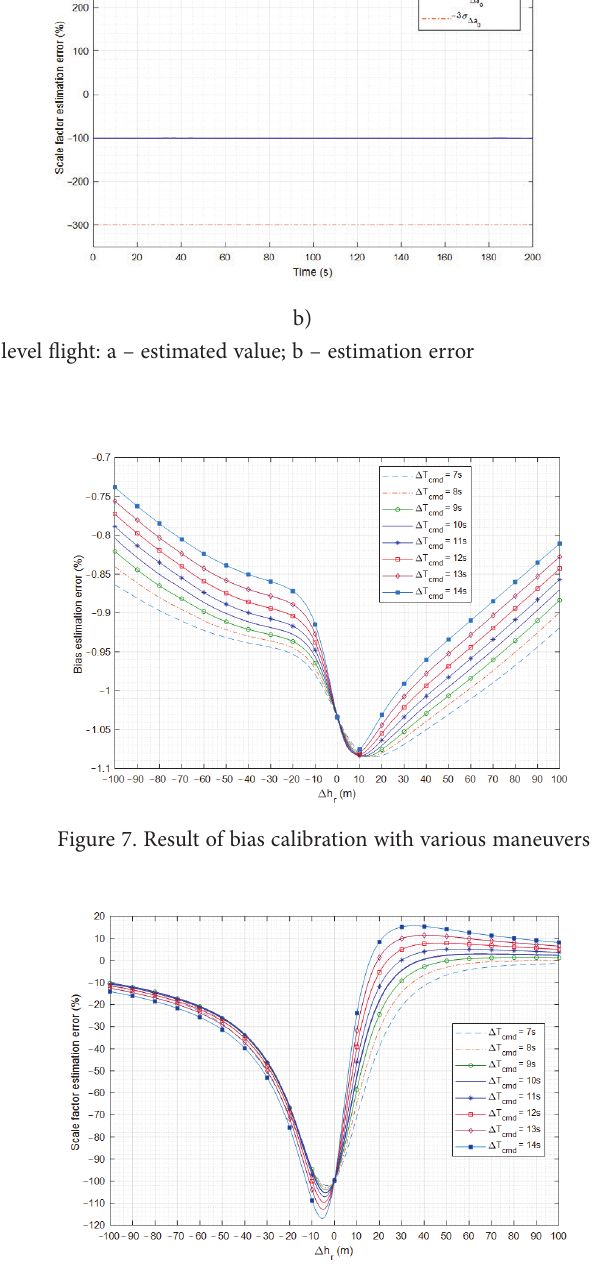
Figure 8. Result of scale factor calibration with various